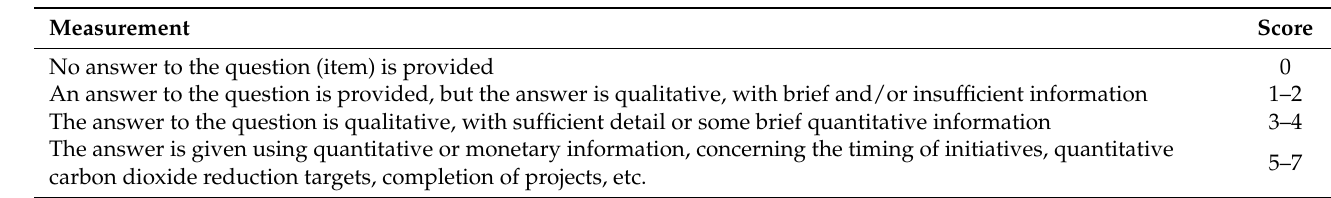
Table 2. Scoring